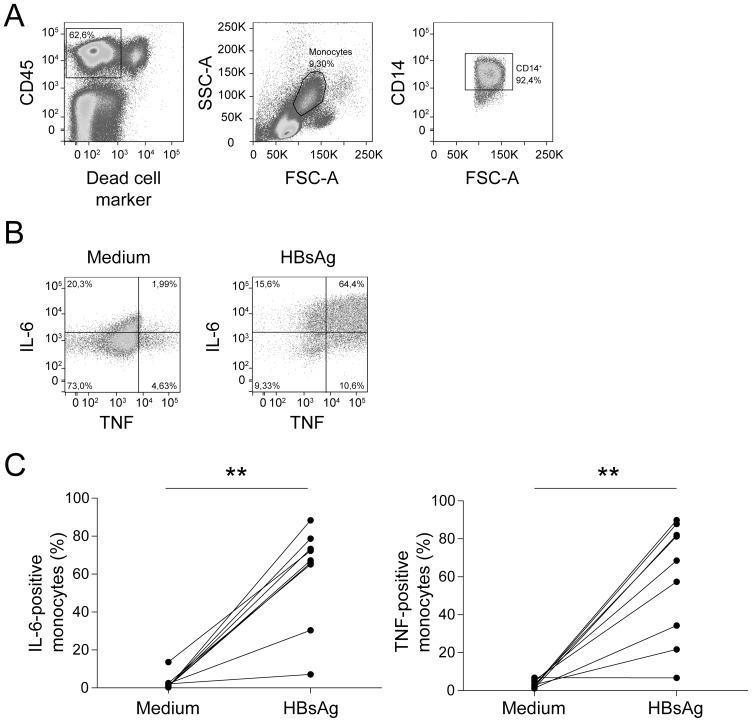
HBsAg induces cytokine production by monocytes.PBMC from healthy individuals were stimulated with HBsAg. After overnight incubation, cells were stained for CD14, IL-6 and TNF. (A) Gating strategy: Viable monocytes were identified on the basis of their forward-sideward scatter profile and their membrane expression of CD14. (B) Representative intracellular cytokine stainings are presented showing IL-6 and TNF-producing monocytes upon incubation with medium and HBsAg. (C) The frequencies of monocytes producing IL-6 or TNF upon incubation with medium or HBsAg are presented (n = 9, ** p<0.01, Wilcoxon signed rank test).